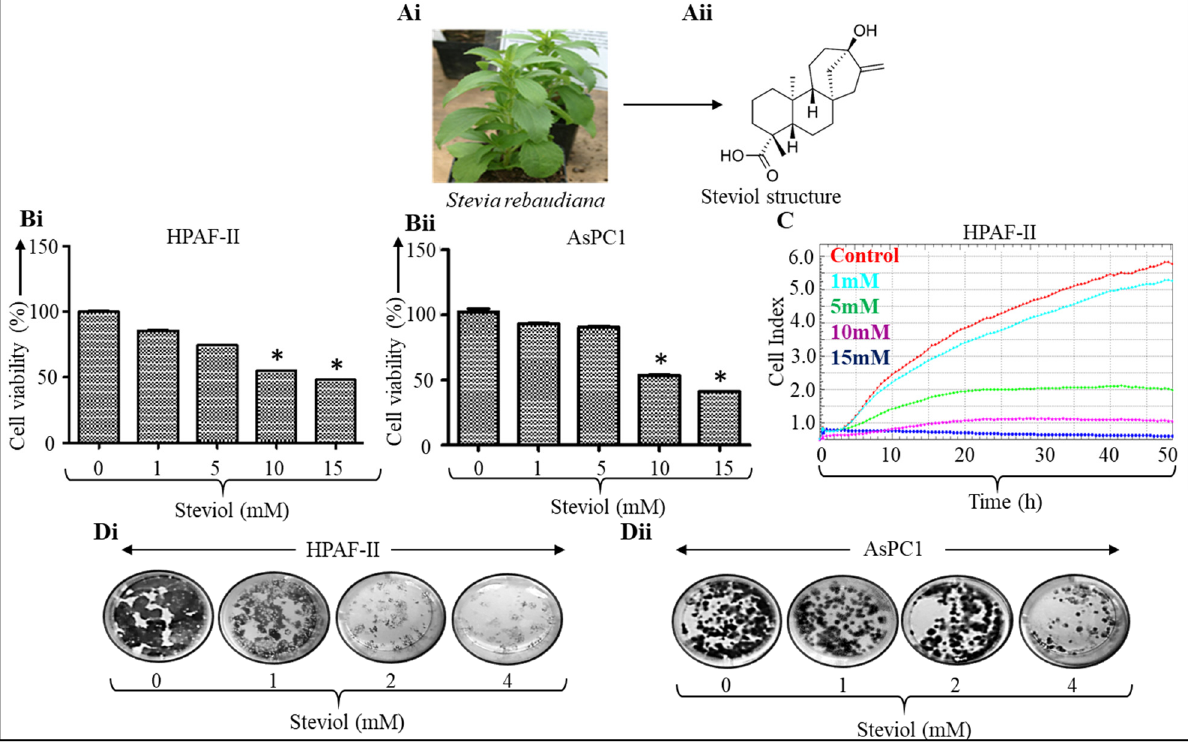
Figure 1. Steviol inhibits cell proliferation and clonogenic potential of pancreatic cancer cells. ( Ai ) A Stevia rebaudiana plant (www.wikipedia.com; accessed on 7 September 2021); ( Aii ) chemical structure of steviol; ( B ) pancreatic cancer cells were treated with different concentrations of steviol (0, 1, 5, 10, and 15 mM) and incubated for 48 h. Cell proliferation assay was terminated after addition of MTT reagent and recording the absorbance in HPAF-II ( Bi ) and AsPC1 cells ( Bii ); n = 3; * p < 0.05. ( C ) The cells were subjected to the xCELLigence instrument and cell proliferation assay (0, 1, 5, 10, and 15 mM of steviol) was conducted on the E-plate; ( D ) colony formation assay was performed on pancreatic cancer cells HPAF-II ( Di ) and AsPC1 ( Dii ). The cells were seeded, and after 4 days, treatment with steviol was performed at different concentrations (0, 1, 2, and 4 mM), and the cells were incubated for another 10 days.